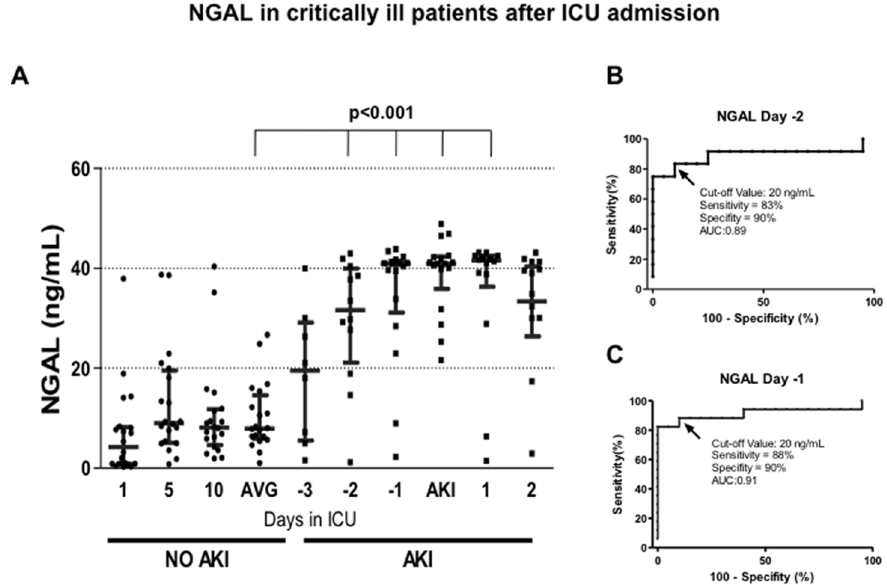
Figure 2. NGAL-1 in critically ill patients after ICU admission. A) Urinary NGAL levels assessed by ELISA from AKI and no-AKI patients. Every point represents the biomarker value in each urine sample, and the lines depicted the mean and 95% confident interval. AVG=average of urinary NGAL levels in no-AKI patients determinated at 1, 5, and 10 days after ICU admission B) Specificity and sensitivity of NGAL to detect AKI two days before the AKIN criteria, as determined by ROC analysis. C) Specificity and sensitivity of NGAL to detect AKI one day before the AKIN criteria, determined by ROC analysis.